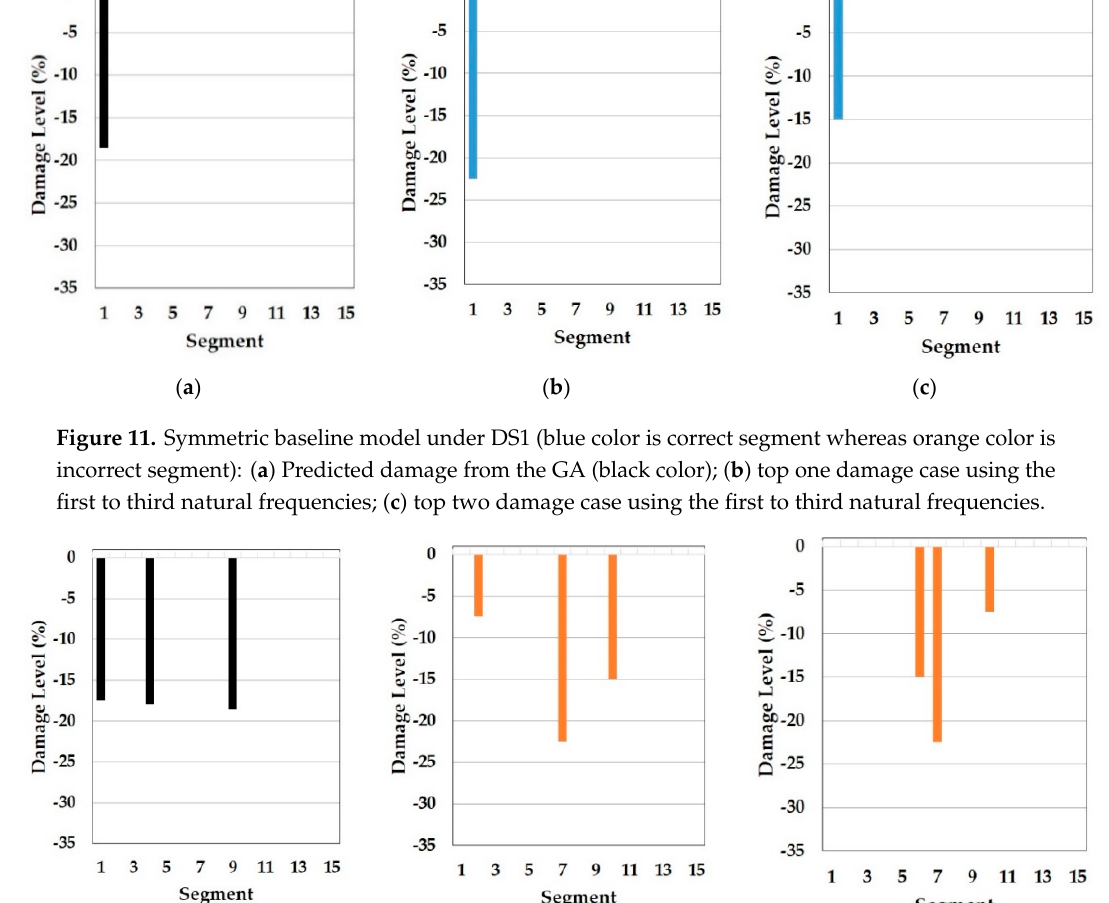
Sensors 2019 , 19 , x FOR PEER REVIEW